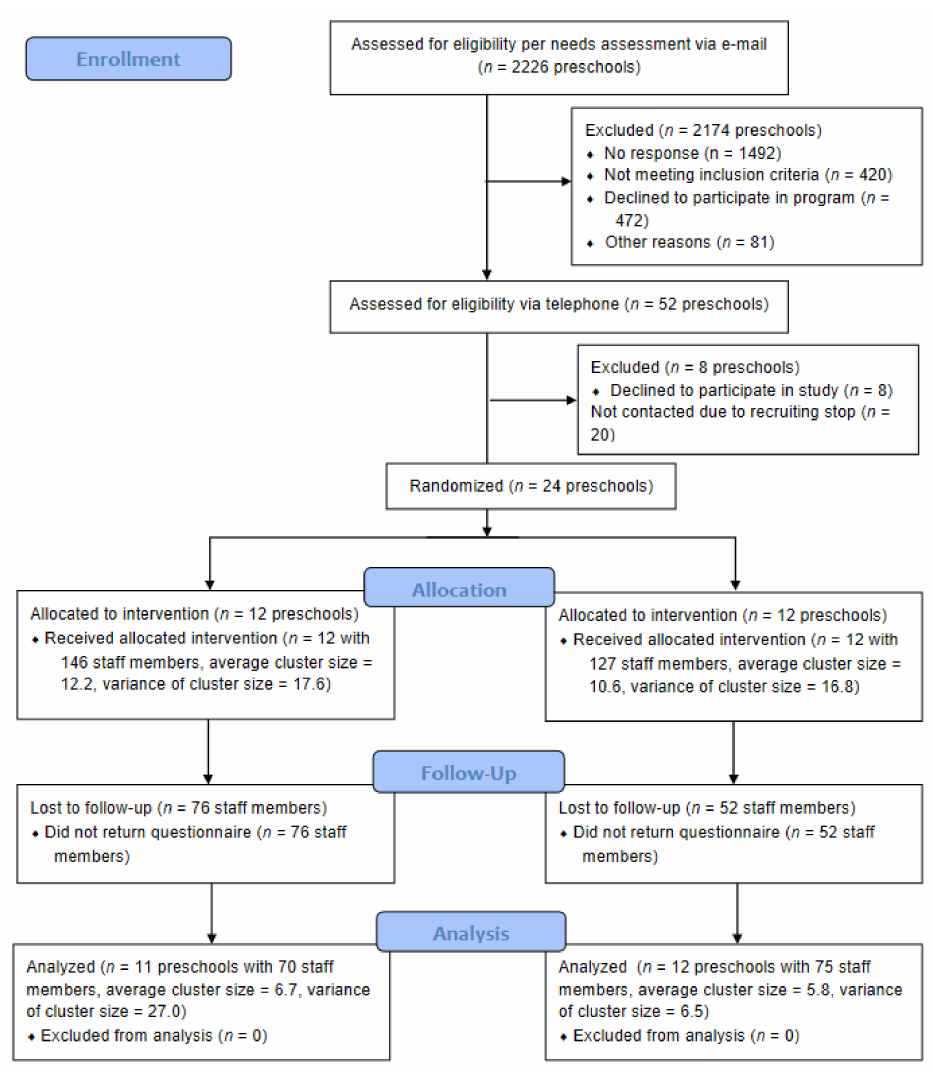
Figure 4. Flowchart for enrollment, baseline measurement, and